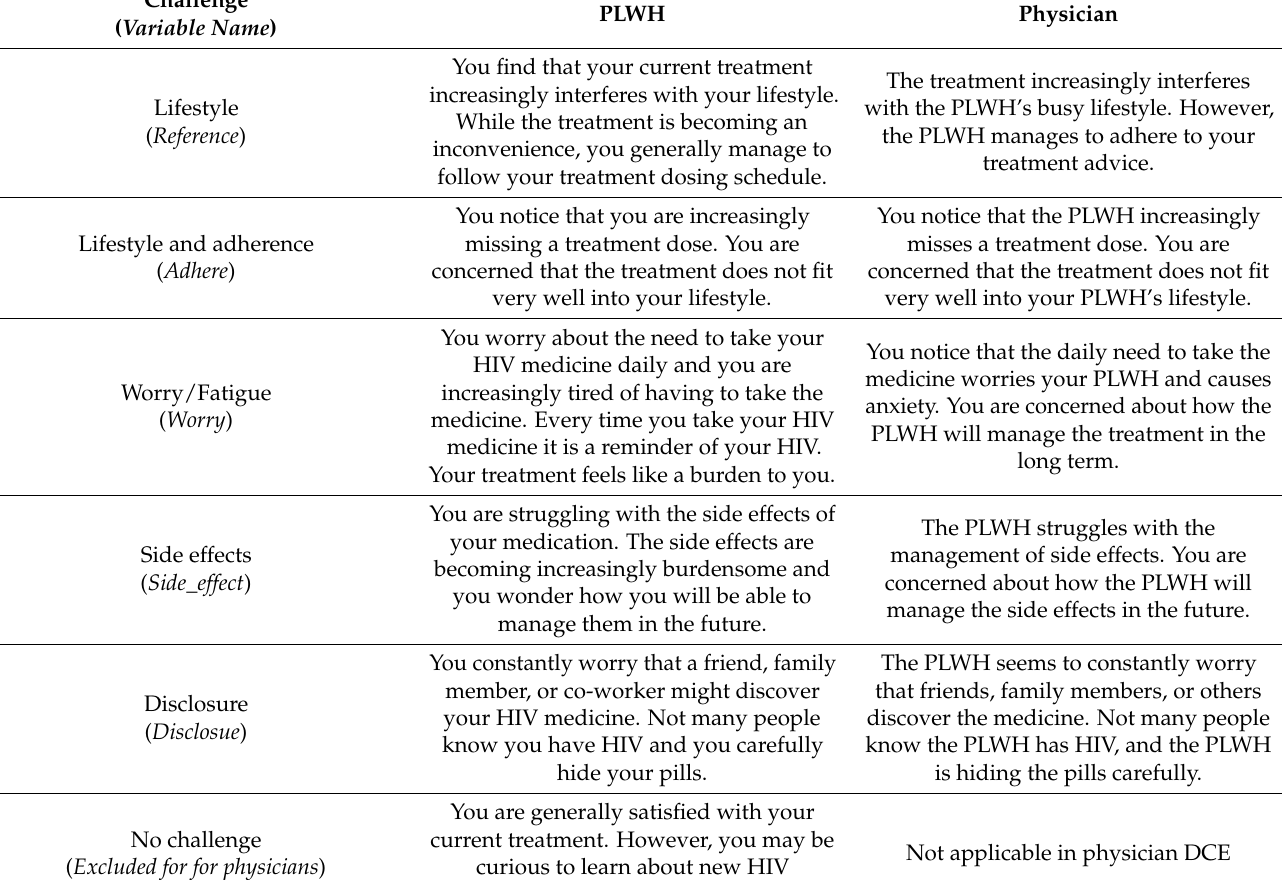
Table 2. Treatment challenge